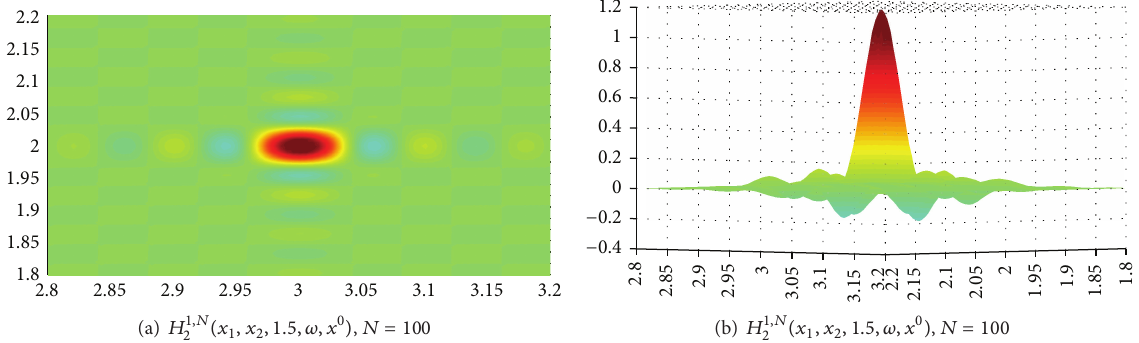
Figure 5: The second component of the first column of regularized magnetic Green’s function.